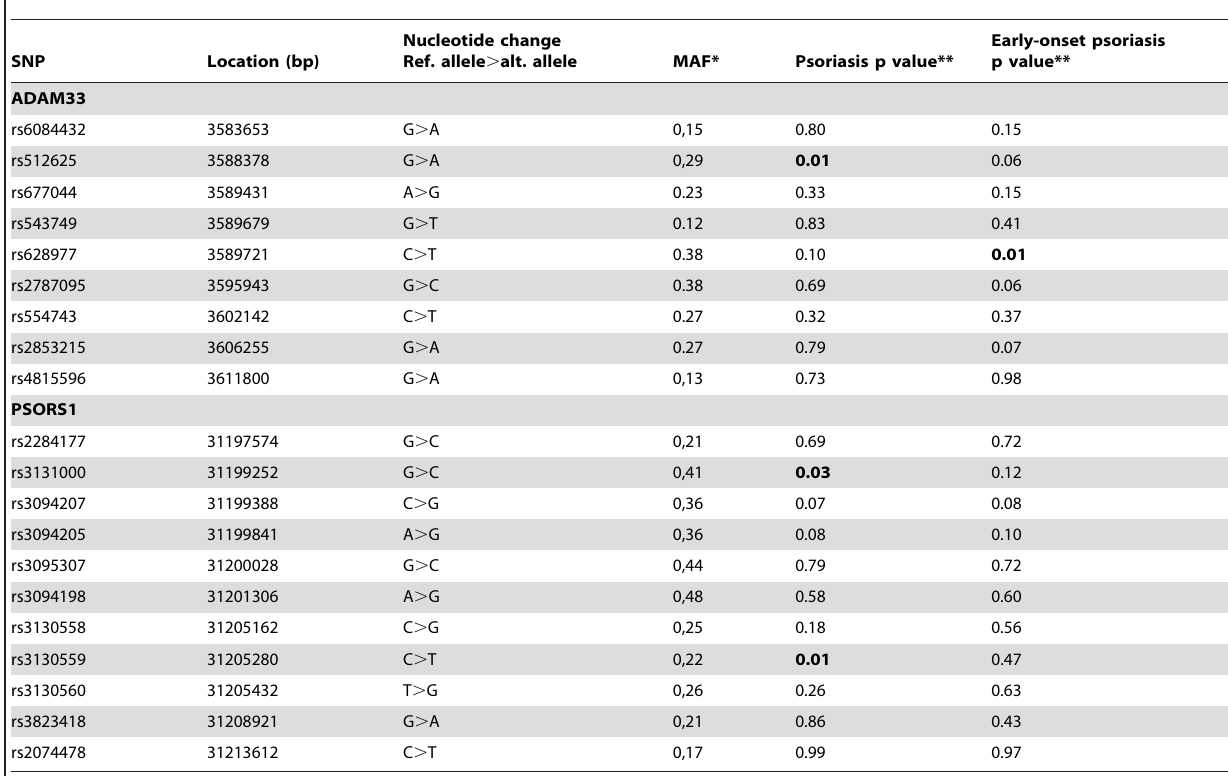
Table 2. Test of association of psoriasis and early-onset psoriasis with ADAM33 and PSORS1 SNPs under a general genetic model using the GEE